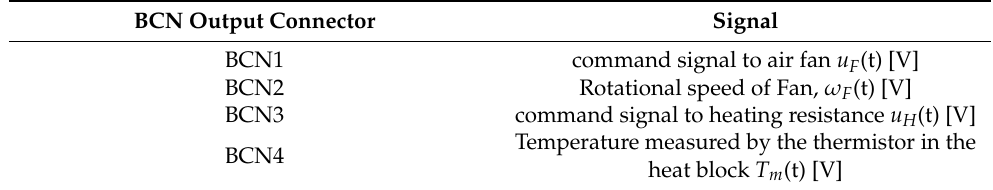
Table 3. Deusto Heater Experimental Setup—Signals in BNC output connectors in the prototype.